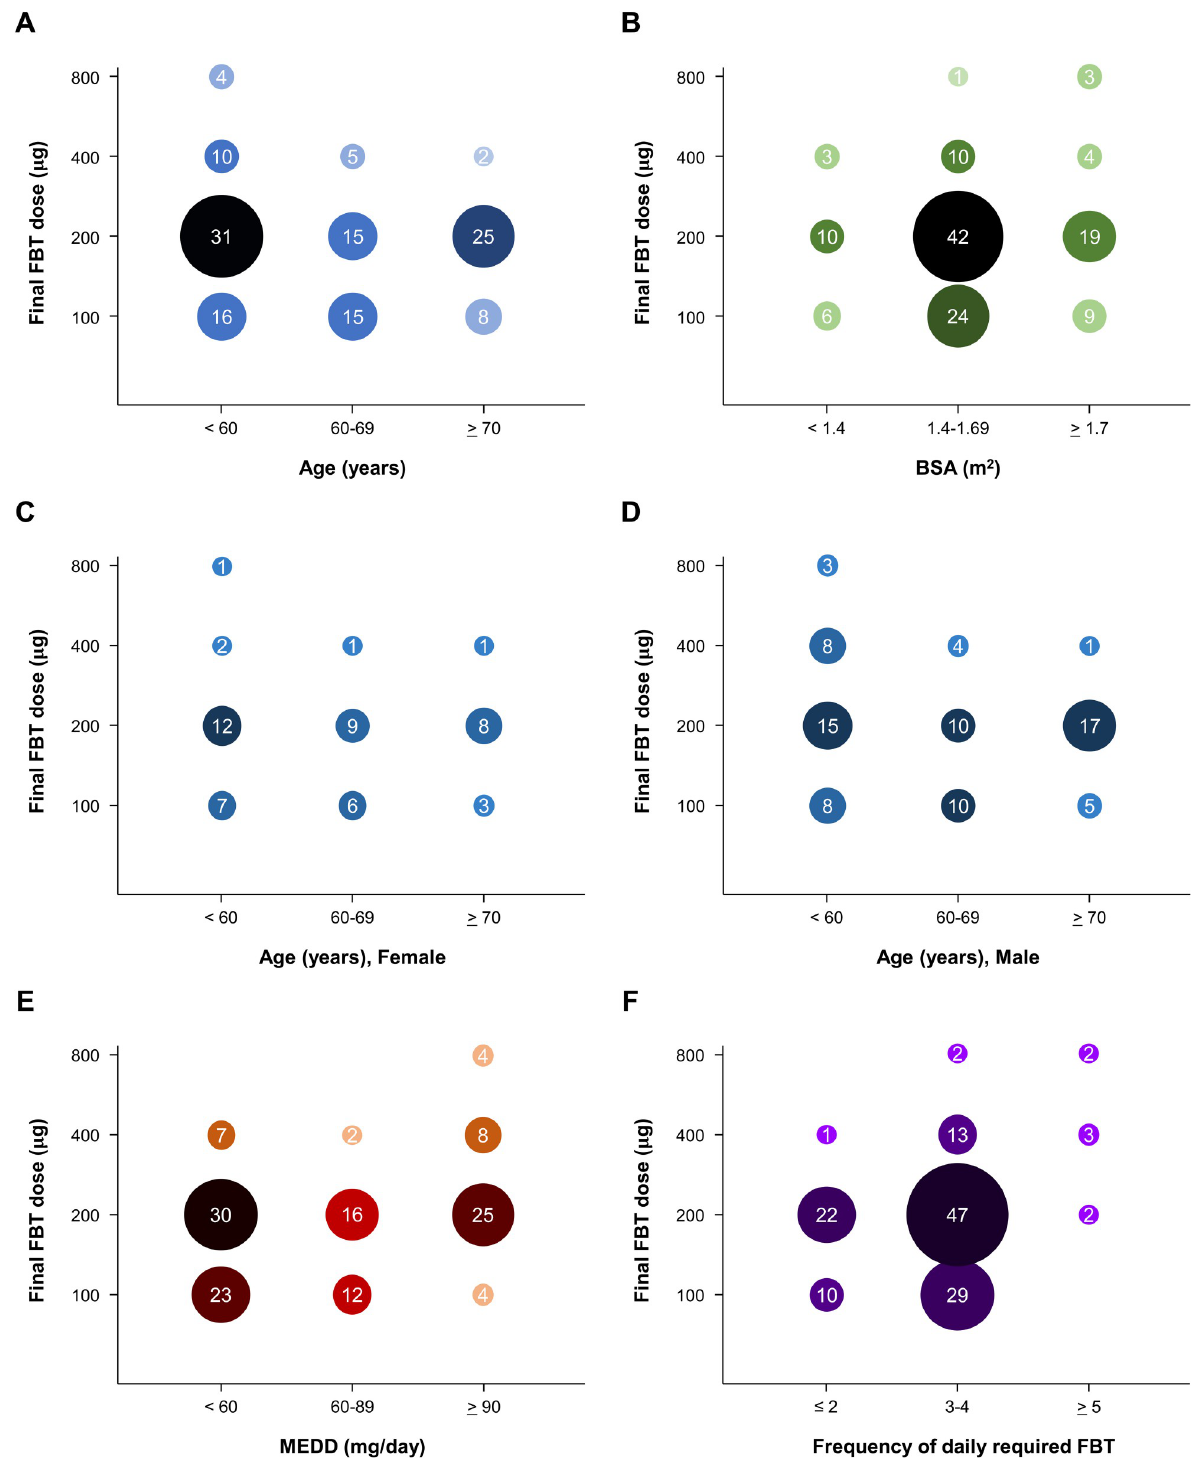
Fig 1. Patient distribution between final dose of fentanyl buccal tablet (FBT) and (a) age, (b) body surface area (BSA), (c) age in females, (d) age in males, (e) oral morphine equivalent daily dose (MEDD), and (f) frequency of daily required FBT use. The number inside each circle indicates the patient count, and the size of the circle correlates with the number of patients.